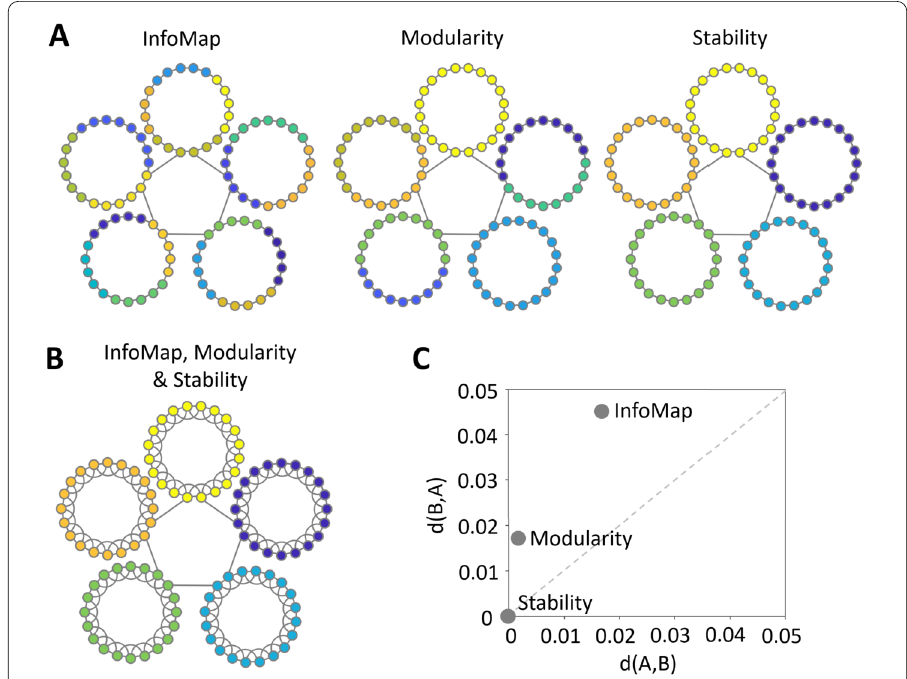
Figure 5 We illustrate how the BiDir distance varies when using three different optimization functions, namely: Modularity, Infomap and stability. In ( A ) and ( B ) we illustrate network A and B, respectively, with node colouring corresponding to the communities detected. In ( C ) we show the BiDir distances obtained when comparing the modular structure of network A and B using each of the different optimization functions. A larger distance is obtained when using the modularity and Infomap function compared to the stability function. This is because the first two functions suffer from a ‘field-of-view’ limit and therefore